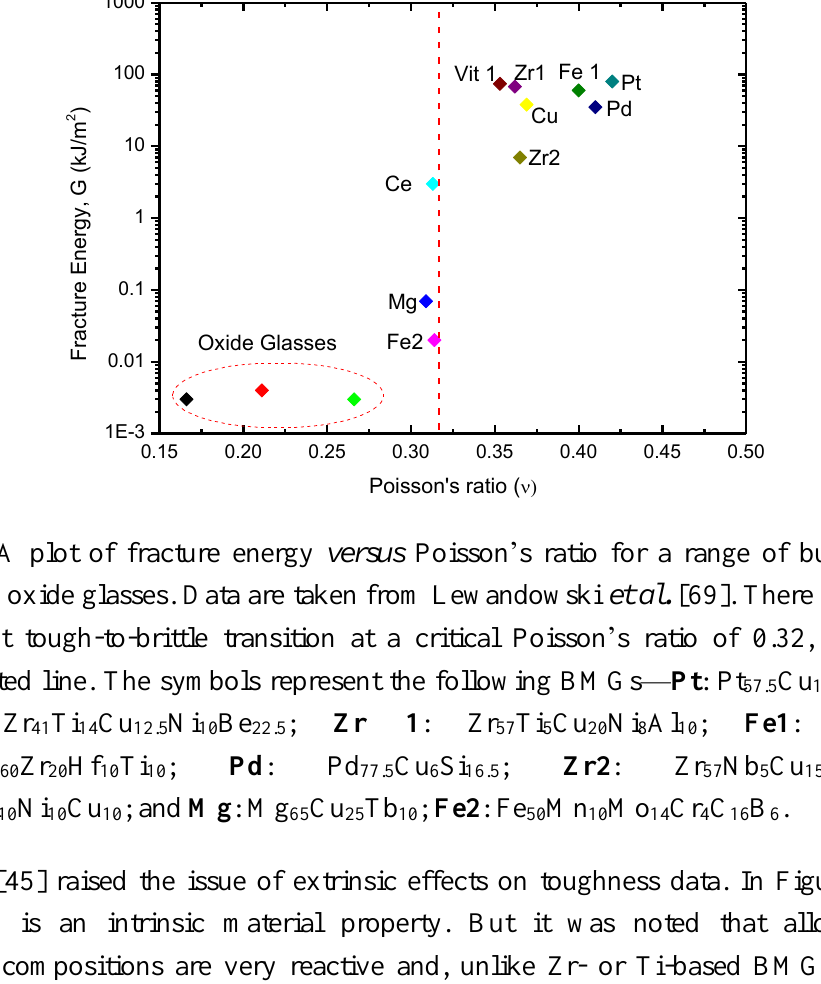
Cu Ni P 57.5 14.7 5.3 22.5